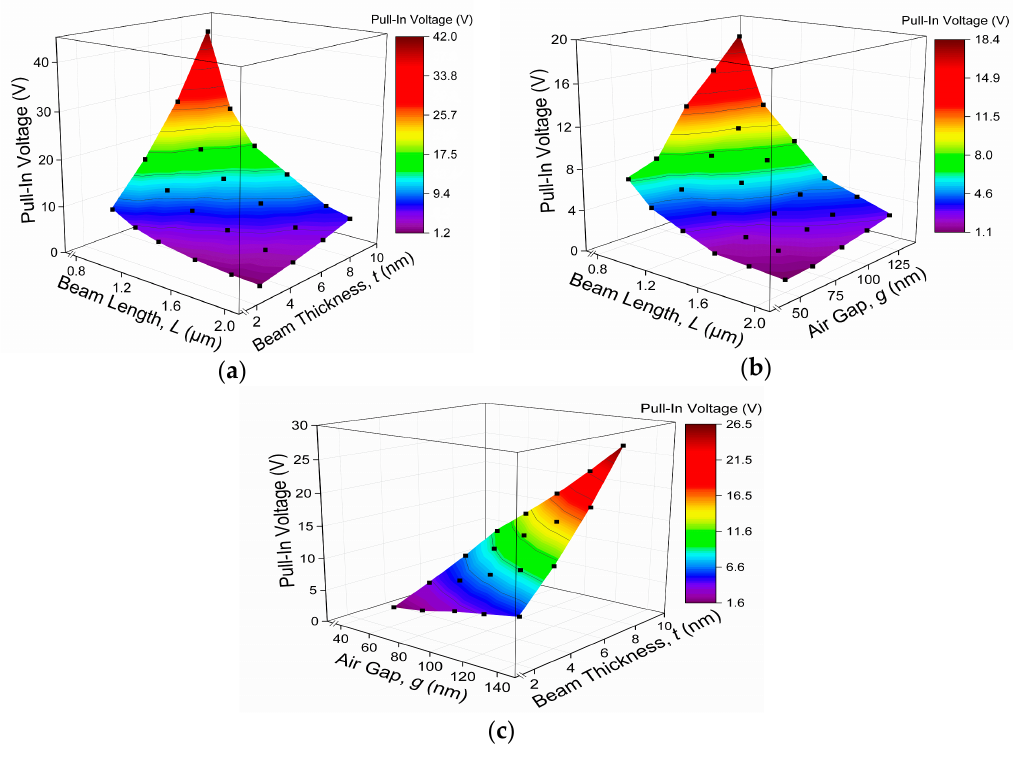
Figure 8. Trends of actuation pull-in voltage dependence of graphene-based NEM switch on: ( a ) beam length and beam thickness; ( b ) beam length and air gap thickness; ( c ) air gap thickness and beam thickness.